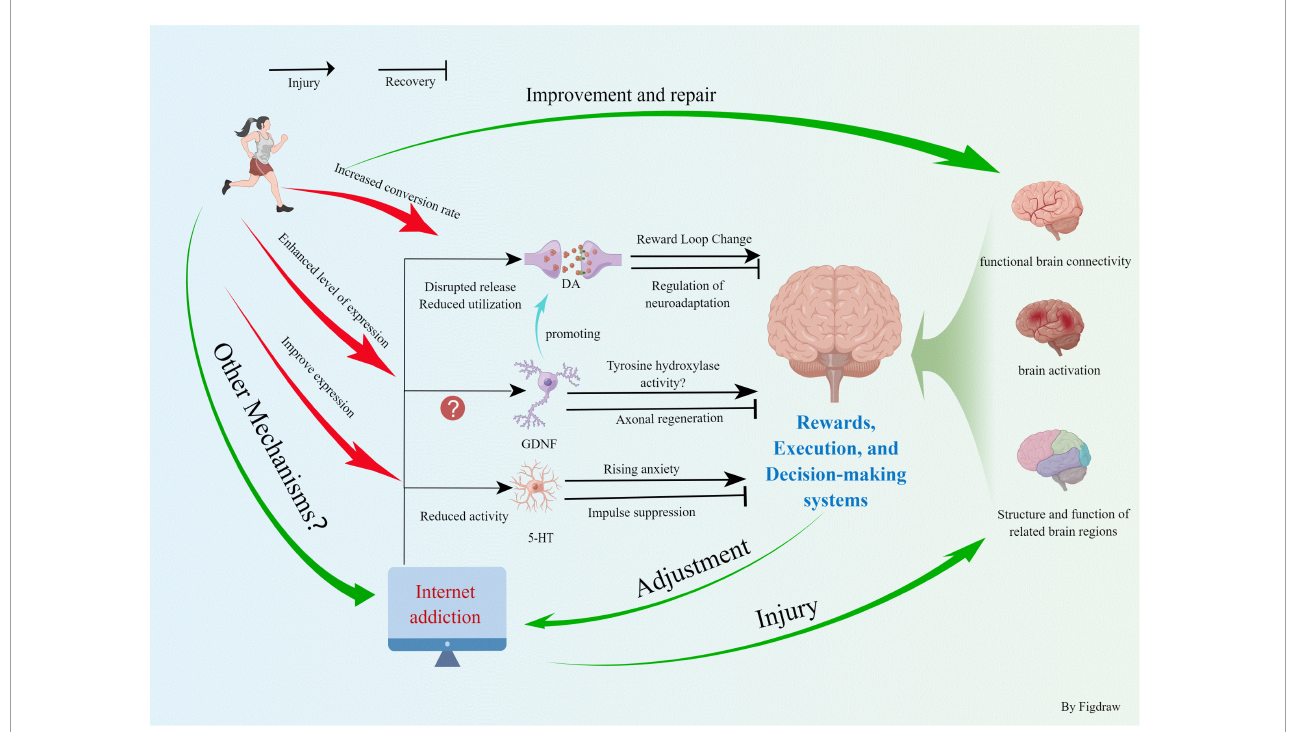
FIGURE2 Exercise improves internet addiction and promotes physical